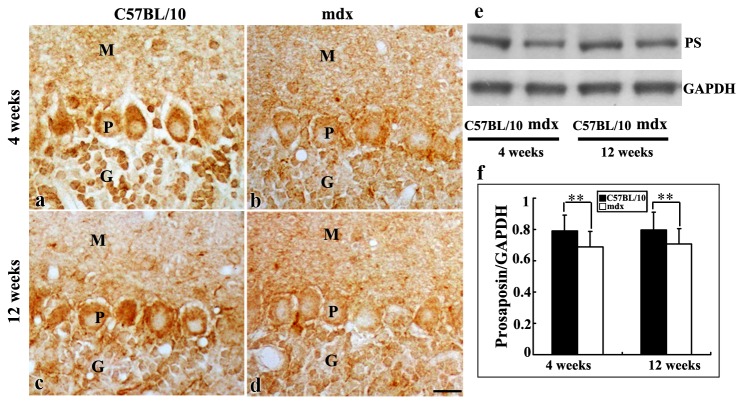
PS in the cerebellum of C57BL/10 and mdx mice, as detected by immunochemistry and Western blotting.
a–d: Light micrographs showing PS immunoreactivity in Purkinje and granule cell bodies in juvenile (a, b) and adult (c, d) C57BL/10 and mdx mice. M, molecular layer; P, Purkinje cell layer; G, granule cell layer. Bars = 20 μm. e: Western blot analysis showing PS as a 65-kDa protein in the cerebellum of juvenile and adult C57BL/10 and mdx mice. Densitometric analysis showed that PS levels were substantially lower in mdx mice than in control mice both at 4 and 12 weeks (f). The results were analyzed by Fisher’s post hoc test (*p < 0.01).